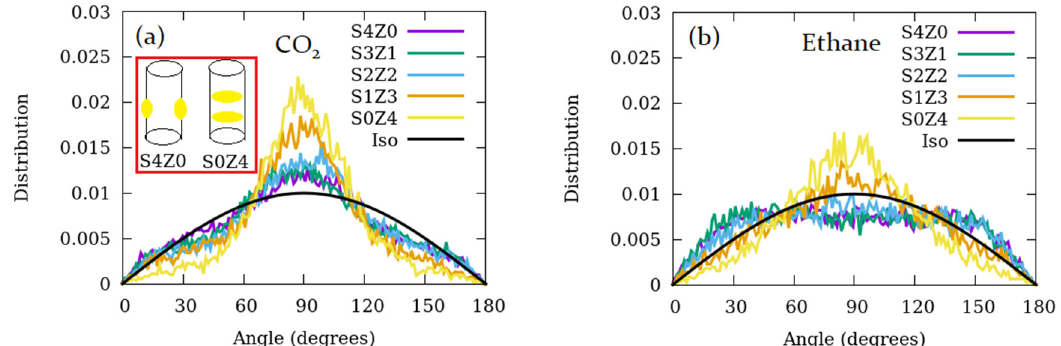
Figure 8. Distribution of angles between the axis of the straight channels and the molecular axis of ( a ) CO 2 and ( b ) ethane molecules adsorbed in the half-blocked systems (yellow portion of Table 1) at a pressure of 100 atm. The schematic in inset of ( a ) shows the position of methane molecules blocking the approach to zigzag or straight channels in the systems S4Z0 and S0Z4. A part of a typical straight channel is shown as a cylinder here, and the methane molecules are shown as yellow discs.